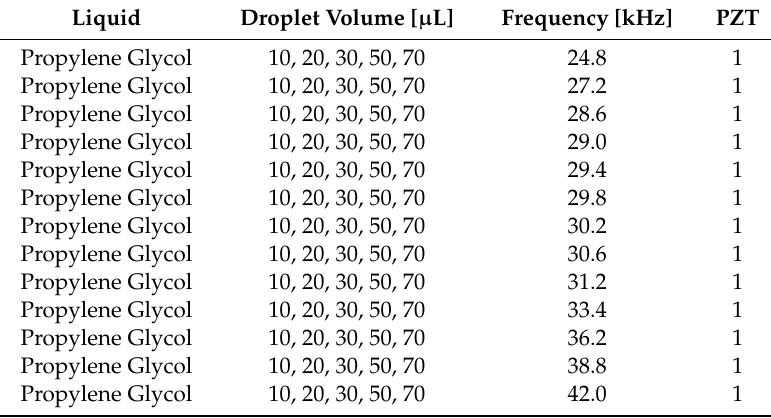
Table A4. Testing parameters used for the experiments conducted with propylene glycol to investigate material property e ff ects.